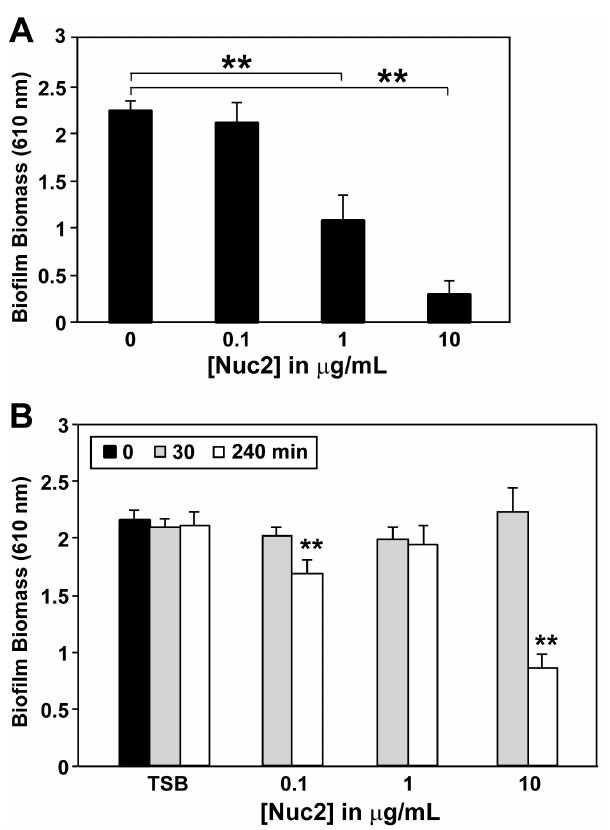
Figure 8. Effect of Nuc2 on S. aureus biofilms. A . Prevention of SH1001 biofilm formation in a microtiter plate assay by addition of purified Nuc2 at doses of 0, 0.1, 1, and 10 m g/mL at the time of inoculation. B . An established SH1001 biofilms is treated with Nuc2 and incubated for 0 (black), 30 (gray), or 240 (white) minutes. Results are representative of 3 trials, with 6 wells per strain measured per trial. Error bars show 1 standard deviation from the average absorbance measured. Statistical significance (**p , 0.0001) was determined by a Student’s T-test.